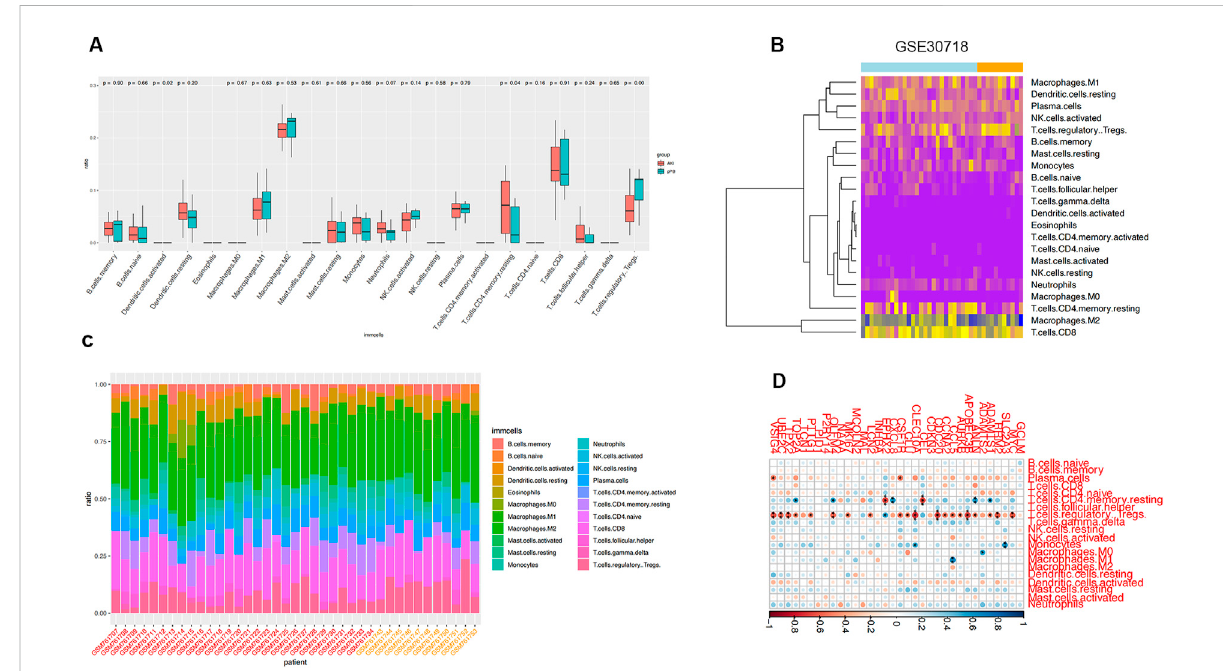
FIGURE 7 Immune in fi ltration analysis. (A) In fi ltration fraction overview of 22 immune cells and comparison ofin fi ltration scores in twogroups;horizontal axis is immune cells and vertical axis is in fi ltration fraction. (B) Immune cell in fi ltration cluster. (C) Proportion of in fi ltrating immune cells. (D) Correlation analysis of ferroptosis genes and immune cells in